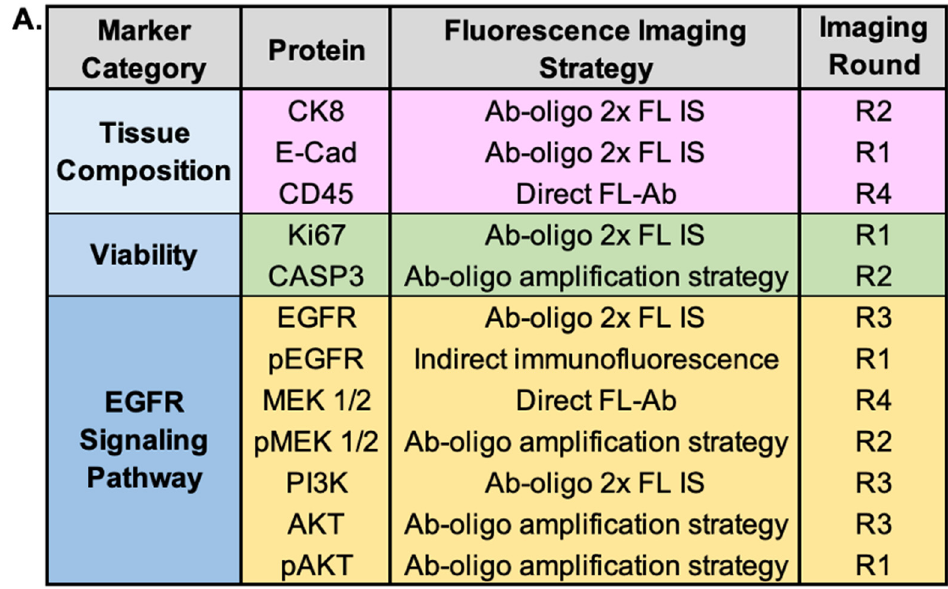
Figure 7. Single Cell Sample Integrity after cyCIF. PBMCs were stained with DAPI (white) and subject to the staining, imaging, and signal removal conditions for ( A ) photochemical quenching and ( B ) Ab-oligo cyCIF. The nuclear staining is shown in a representative region of interest after rounds 1-3, where the inlaid image shows the nuclear morphology after round 3. ( C ) DAPI nuclear staining was used to quantify the proportion of remaining cells for photochemical bleaching and Ab-oligo cyCIF after rounds 1–3. Images shown are representative of multiple fields of view and quantification results are reported as a representative average of all images. Scale bar = 50 μ m.